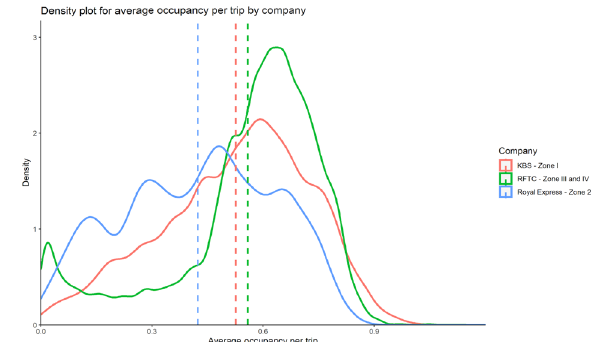
Fig. 3 Distribution of average occupancy rates by the operator. Source: Own representation, GoMetro